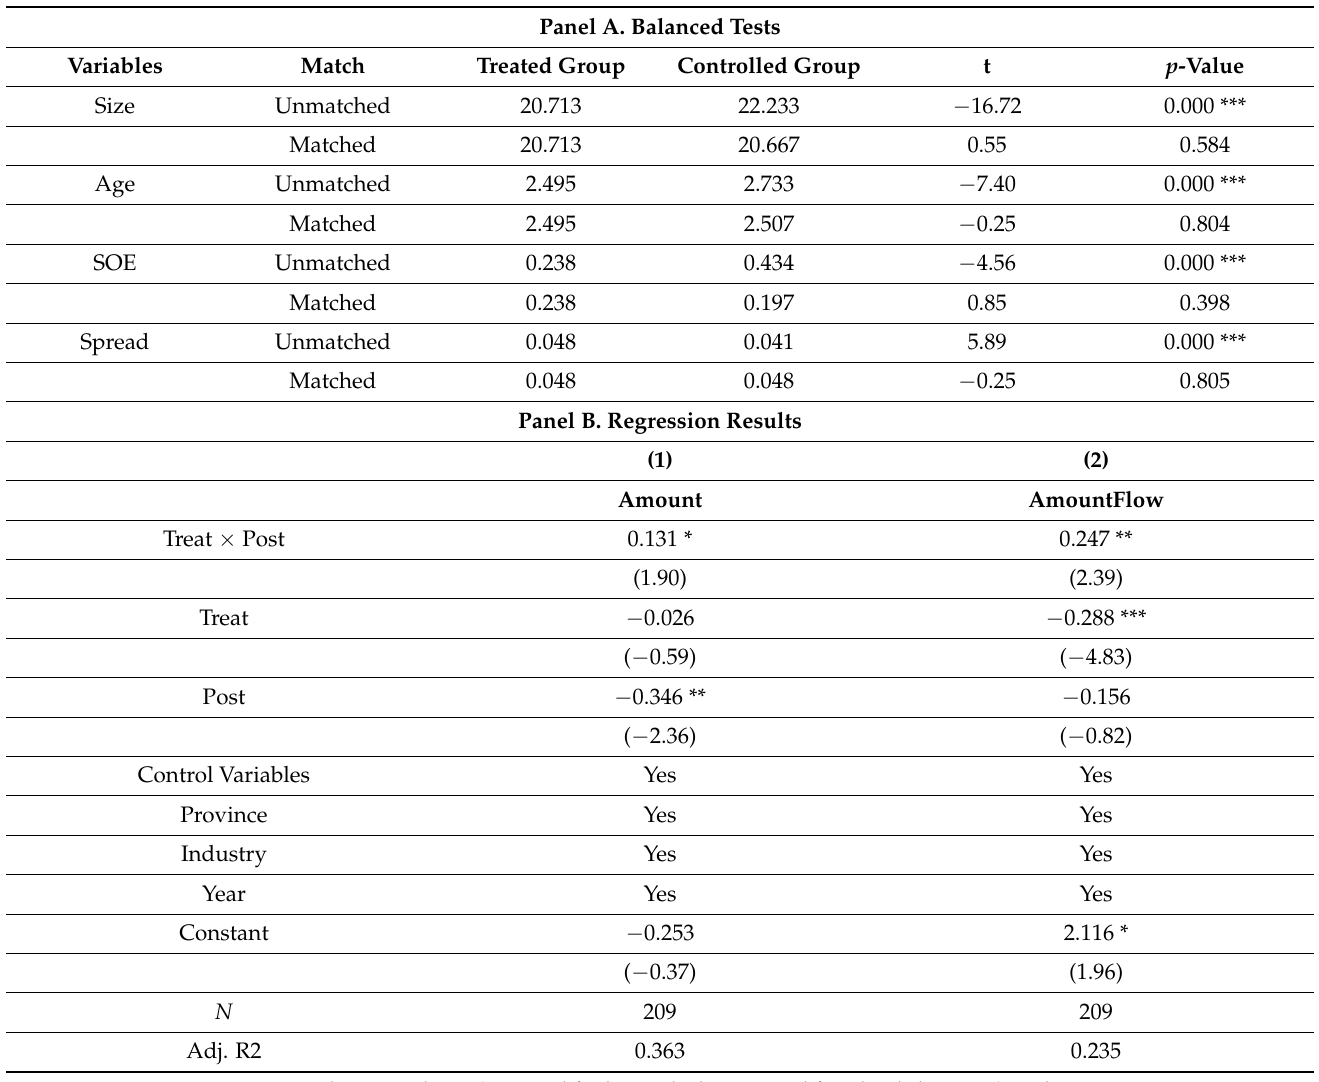
Panel B. Regression